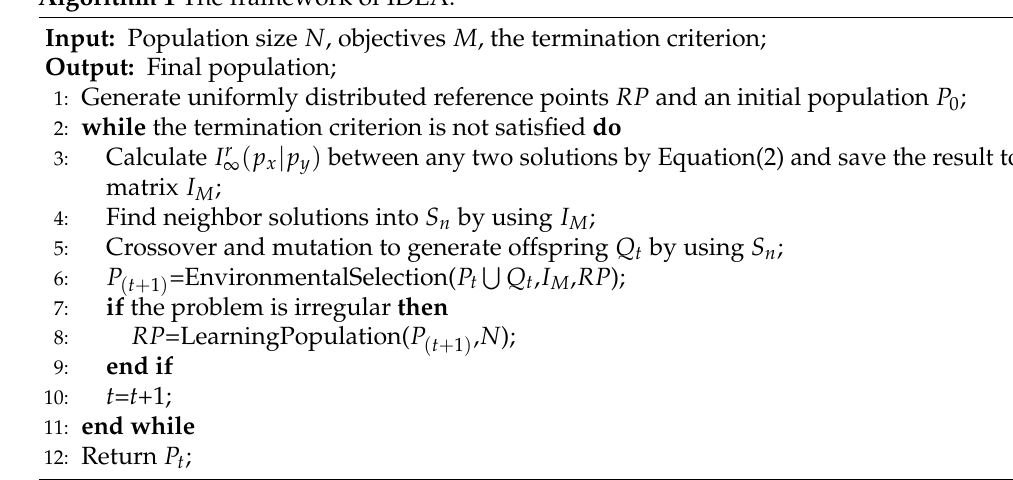
Algorithm 1 The framework of